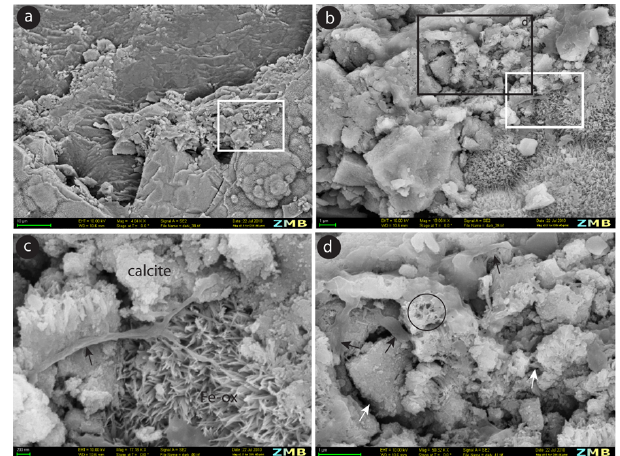
Fig. 13. Secondary electron images of the relationships between dark-brown crusts and calcite crystals: (a, b) partial dissolution of calcite rhomboedra as shown by the porous texture (black square); (c, d) irregular outlines of calcite rhombs (white arrows) closely as- sociated with microorganisms (black